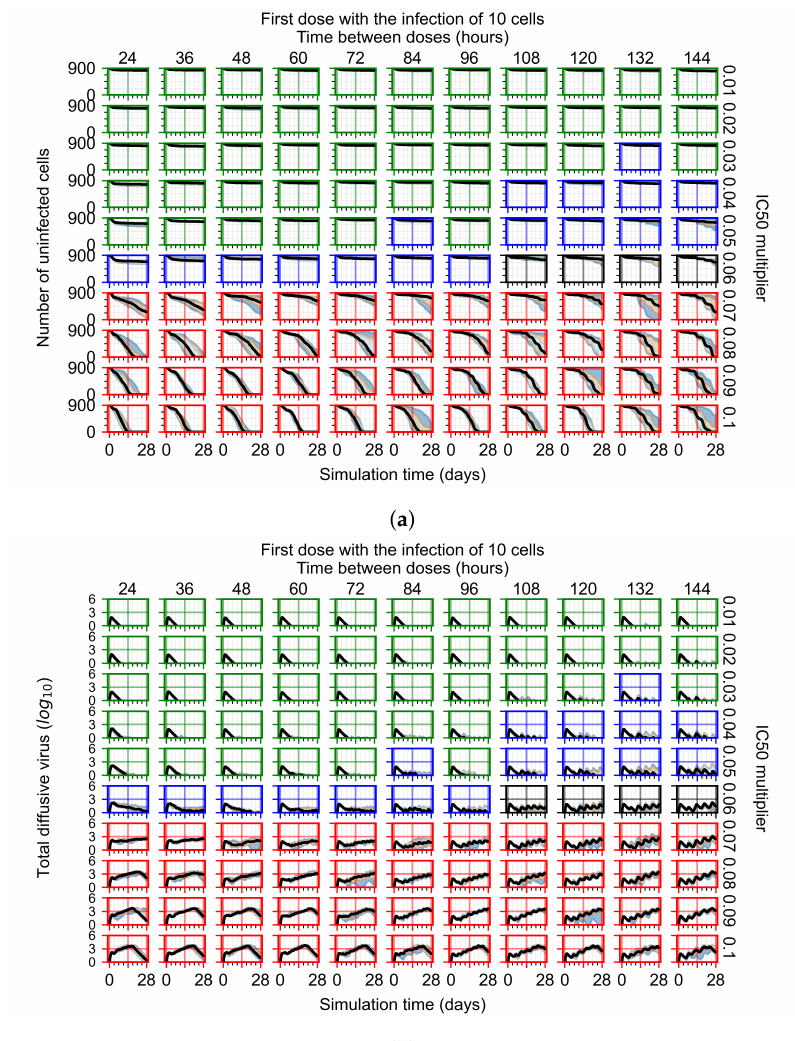
Figure 7. Treatment starts with the infection of 10 epithelial cells. For all subfigures, the median measurement of simulation replicas is the black line, the 0th to 100th quantiles are shaded as dark blue, 10th to 90th shaded in orange, and 25th to 75th as light blue. Rapid clearance plot axis in green, slow clearance plot axis in blue, partial containment in black, and widespread infection in red. ( a ) Uninfected cell population. ( b ) Extracellular diffusive virus; y axis in log scale, and exponent values as tick